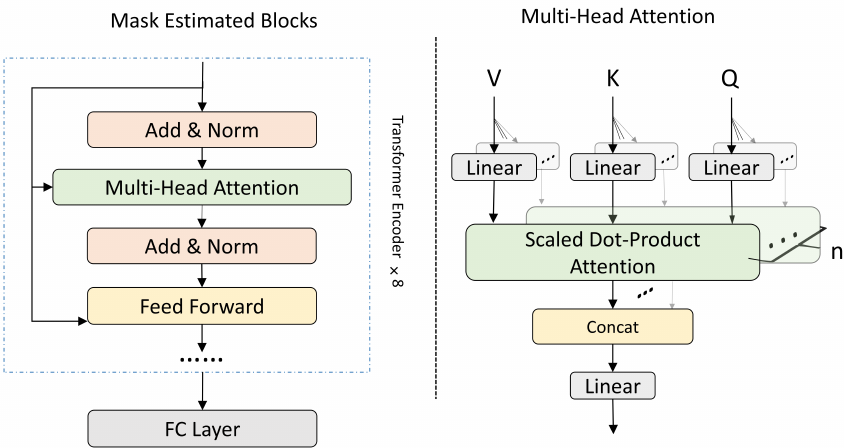
Figure 4. Structure of the MEB. Its main body is an 8-layer Transformer encoder with a fully connected layer. In the experiment, we set the n to